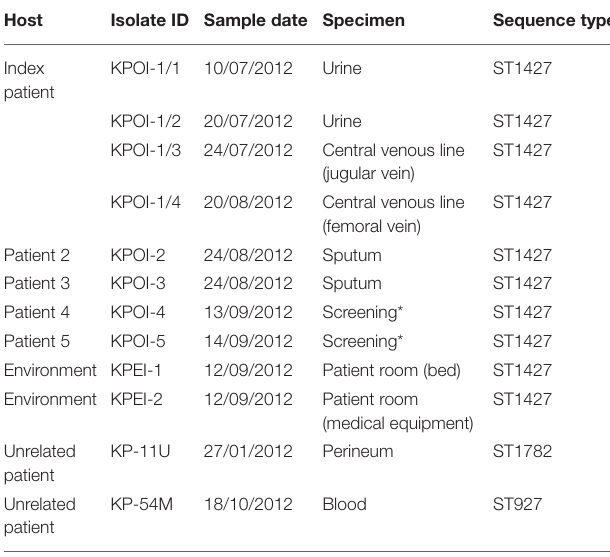
TABLE 1 | K. pneumoniae strains used in this